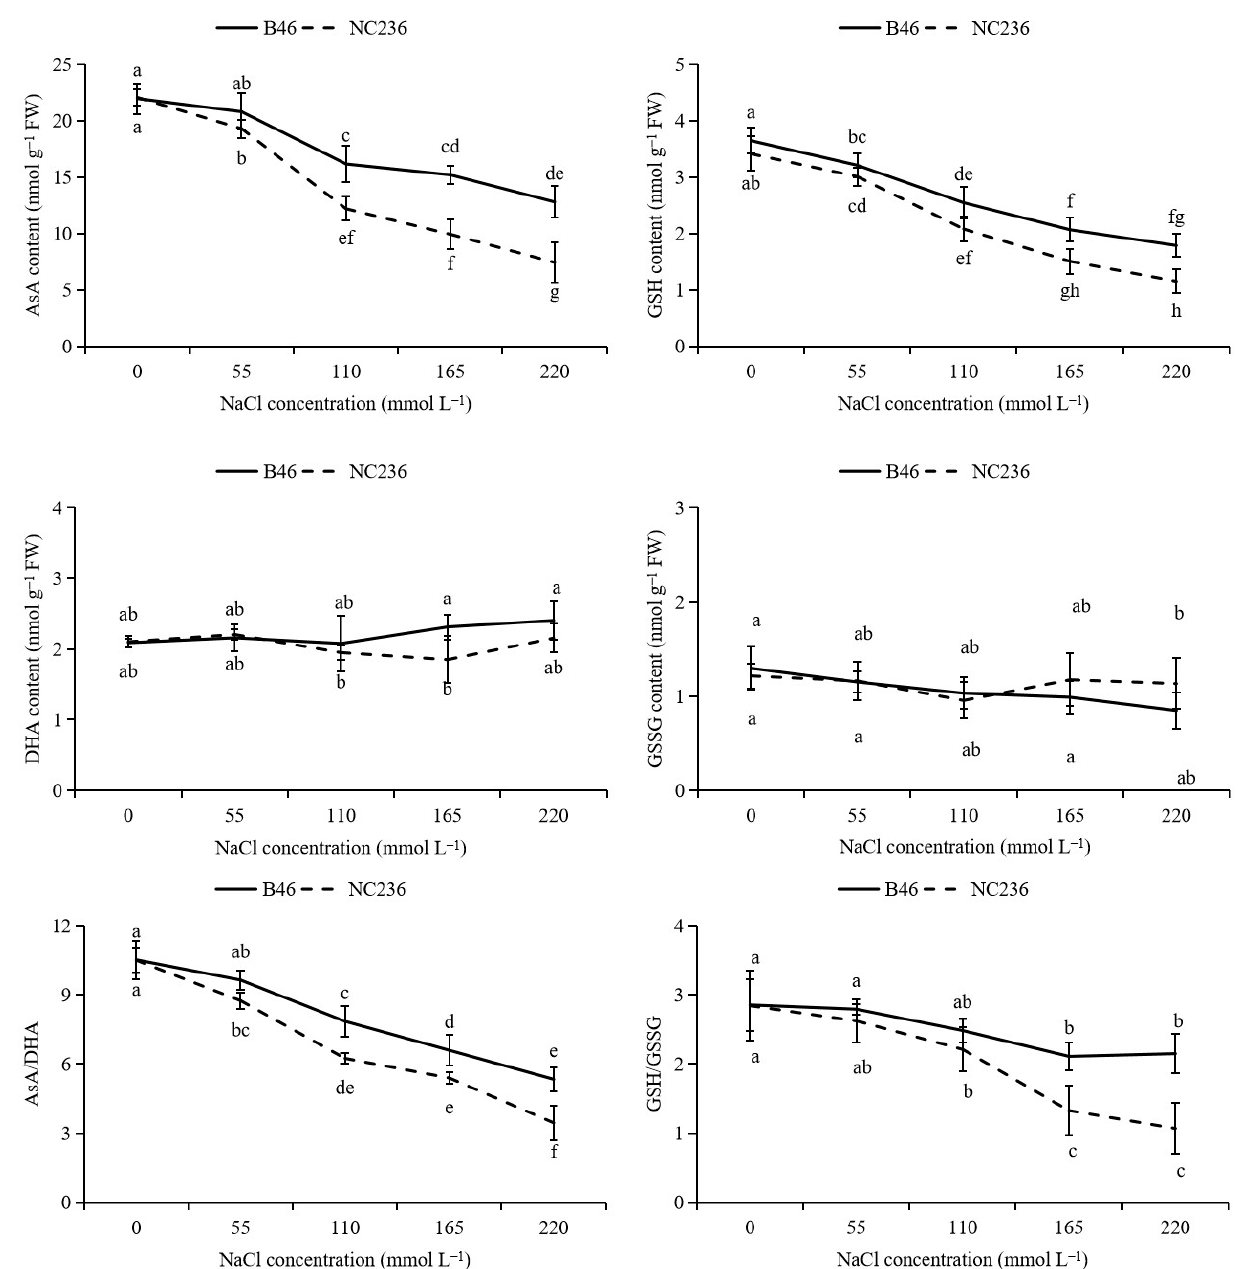
Figure 4. Effect of salt stress on the contents of AsA, DHA, reduced GSH, oxidized GSSG, the ratio of AsA/DHA, and GSH/GSSG in maize leaves. Data are expressed as mean ± standard deviation. Different letters within the same column indicate significant difference at the 5% level.